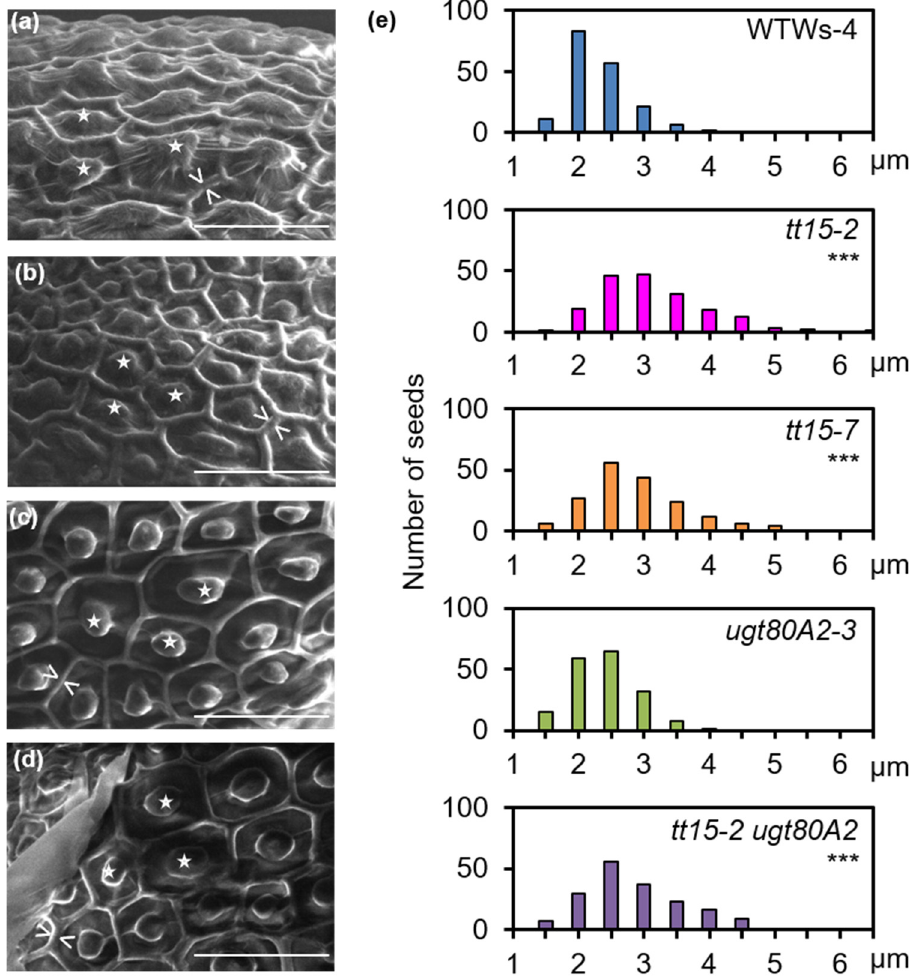
Figure 7. Mutation of TT15 causes increased thickening of radial walls of seed coat epidermal cells. SEM images of seeds before ( a , b ) or after imbibition in water followed by drying ( c , d ). ( a , c ) wild type Ws-4; ( b , d ) tt15-2 . Asterisks indicate columella and white arrows the outer edges of radial cell walls. Bars: 50 µm. ( e ) Quantification of the width of radial walls of 180 cells from 30 different dry, untreated seeds of each indicated genotype. Kruskal-Wallis test compared to wild type *** p < 0.01. tt15-2 A2 , tt15-2 ugt80A2. All genotypes are in the Ws-4 background. Similar results were obtained in an independent experiment using biological replicates for each genotype (Figure S6).